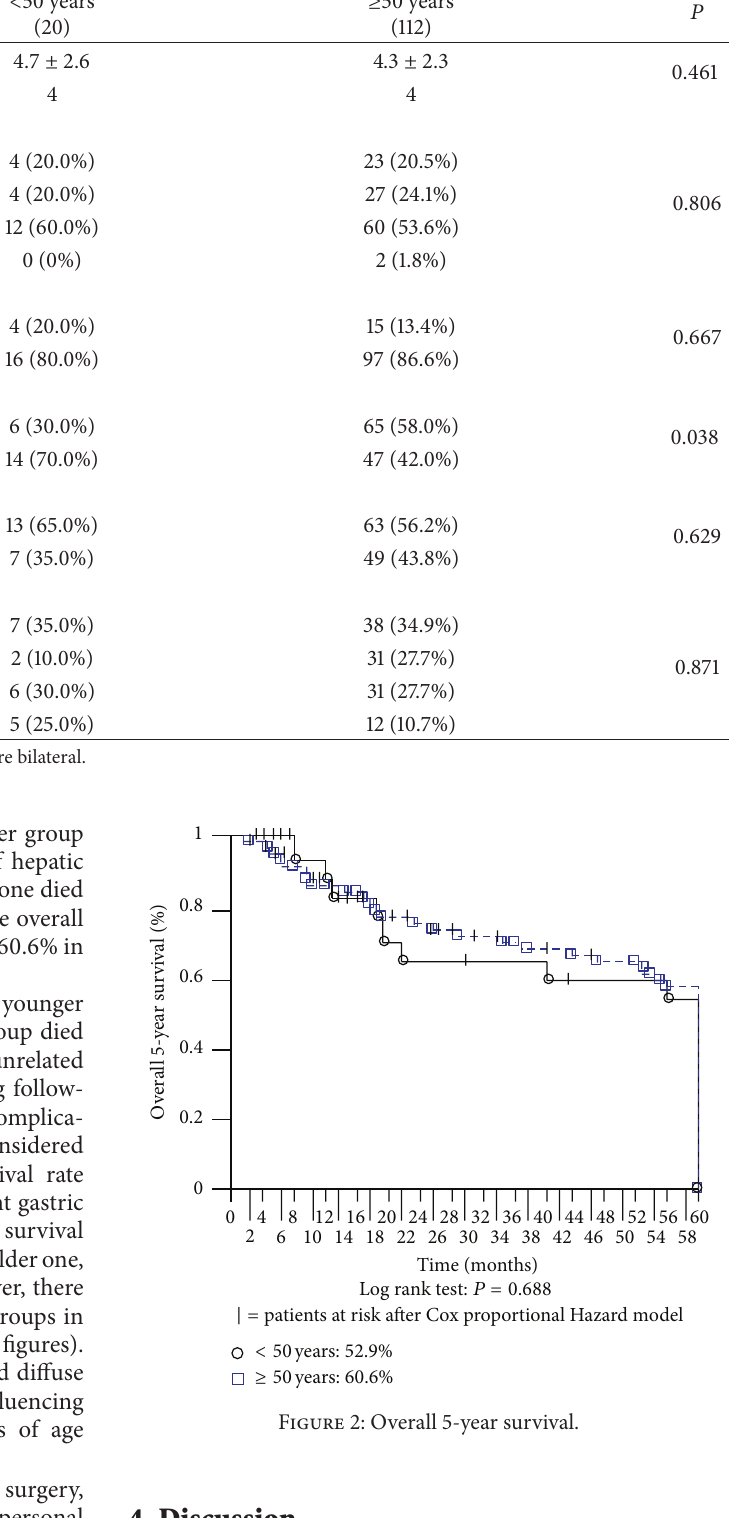
Log rank test: P = 0.688 | = patients at risk after Cox proportional Hazard model